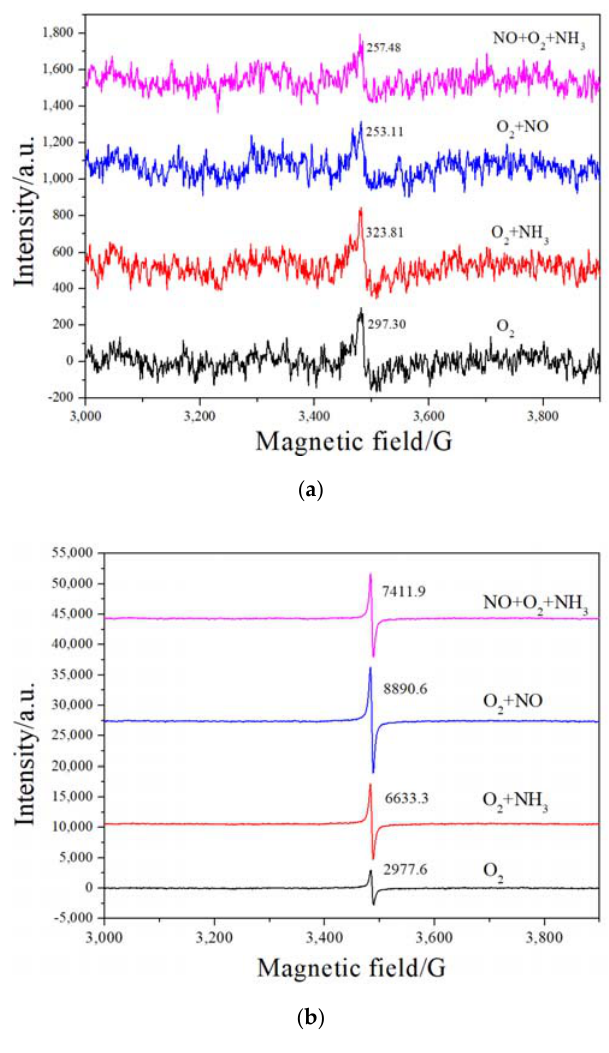
Figure 9. Electron paramagnetic resonance (EPR) spectra profiles of Ce/Ti-400 ( a ) and Ce-Ti-400 ( b ).